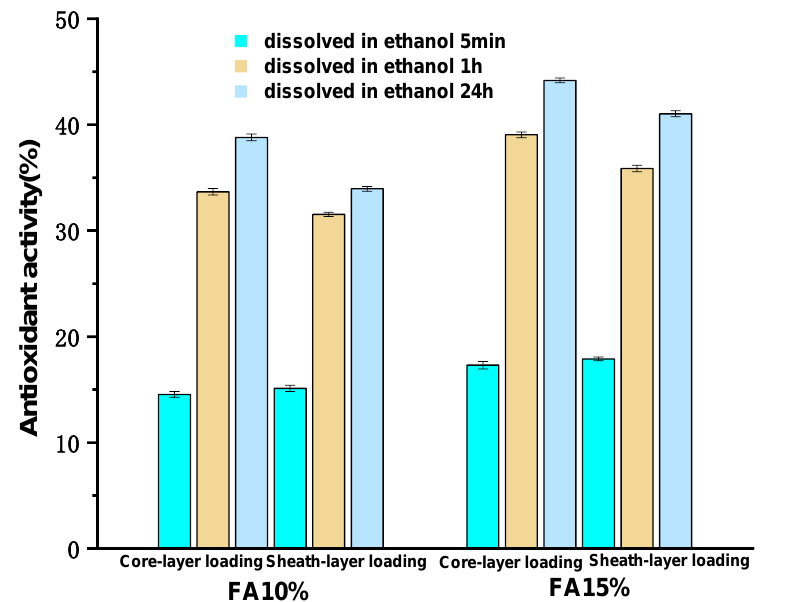
Figure 11. Analysis of the antioxidant activity tests on the fibers.